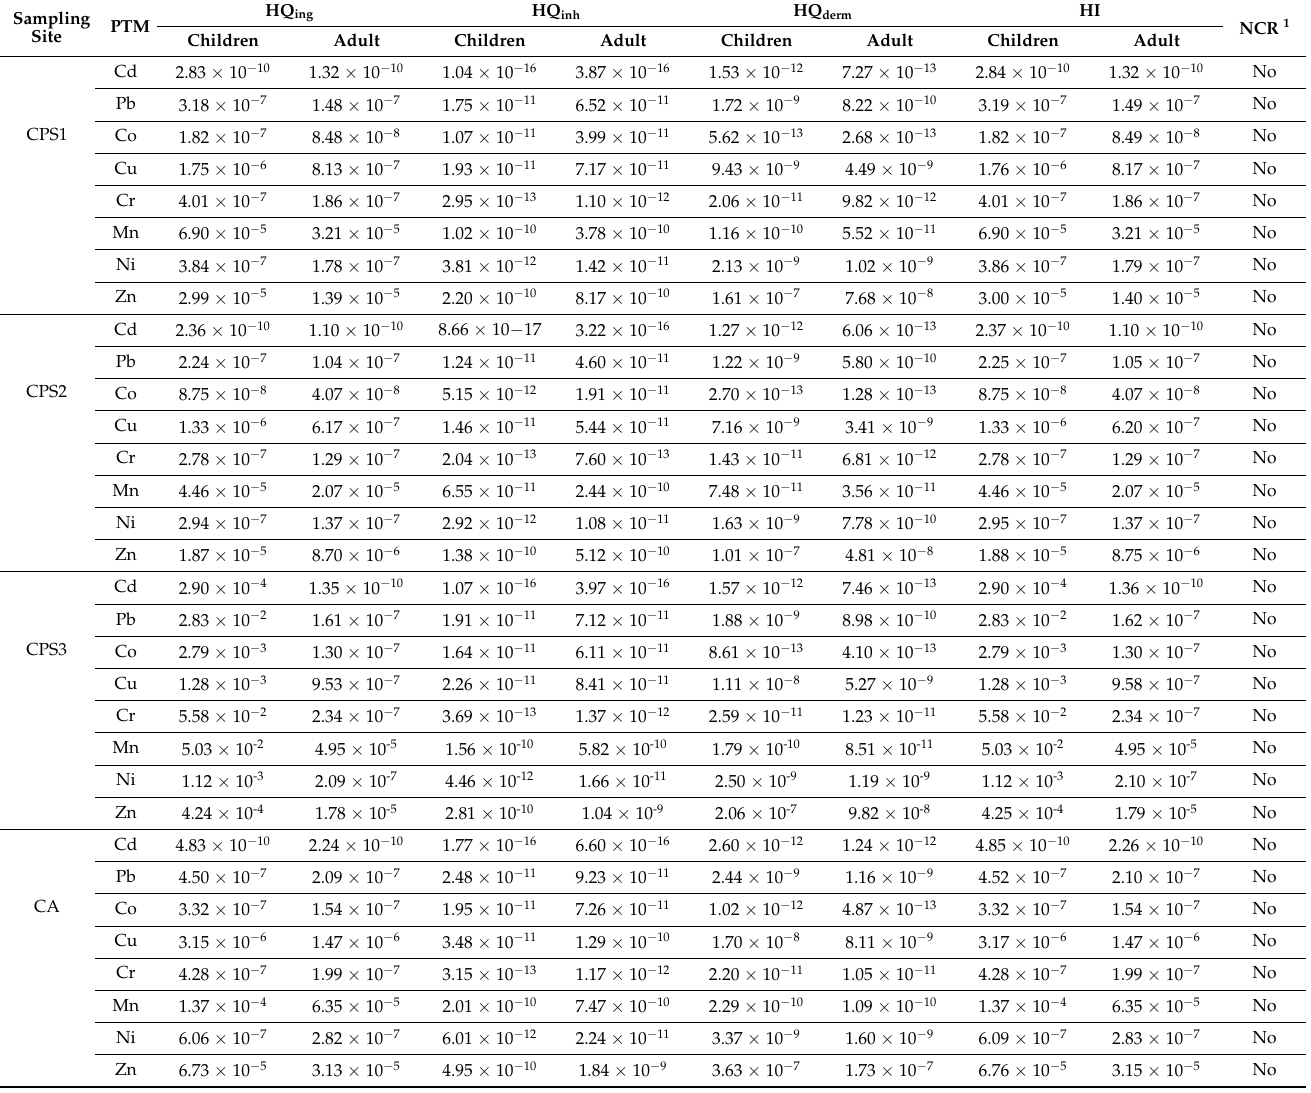
Table 4. Calculated enrichment factor (EF) of PTM from CA and CPS soil samples.